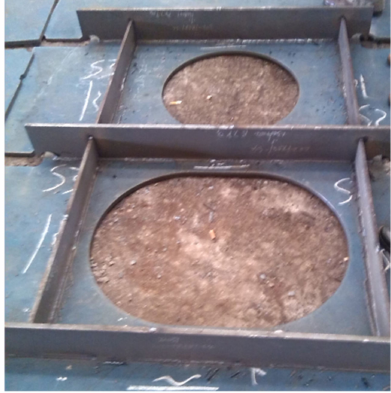
Figure 1. T-profile steel plate for shipbuilding after